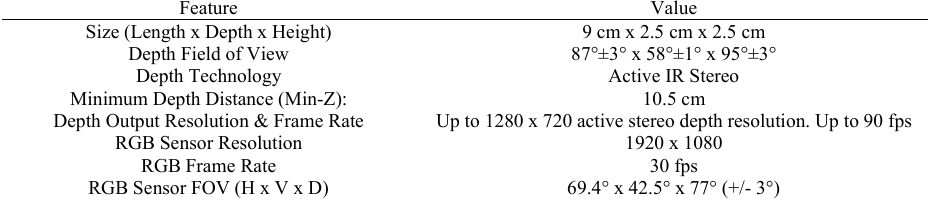
Fig. 10 Realsense D435 (image taken from: https://www.intelrealsense.com/) TABLE 1. REALSENSE D435 SPECIFICATION